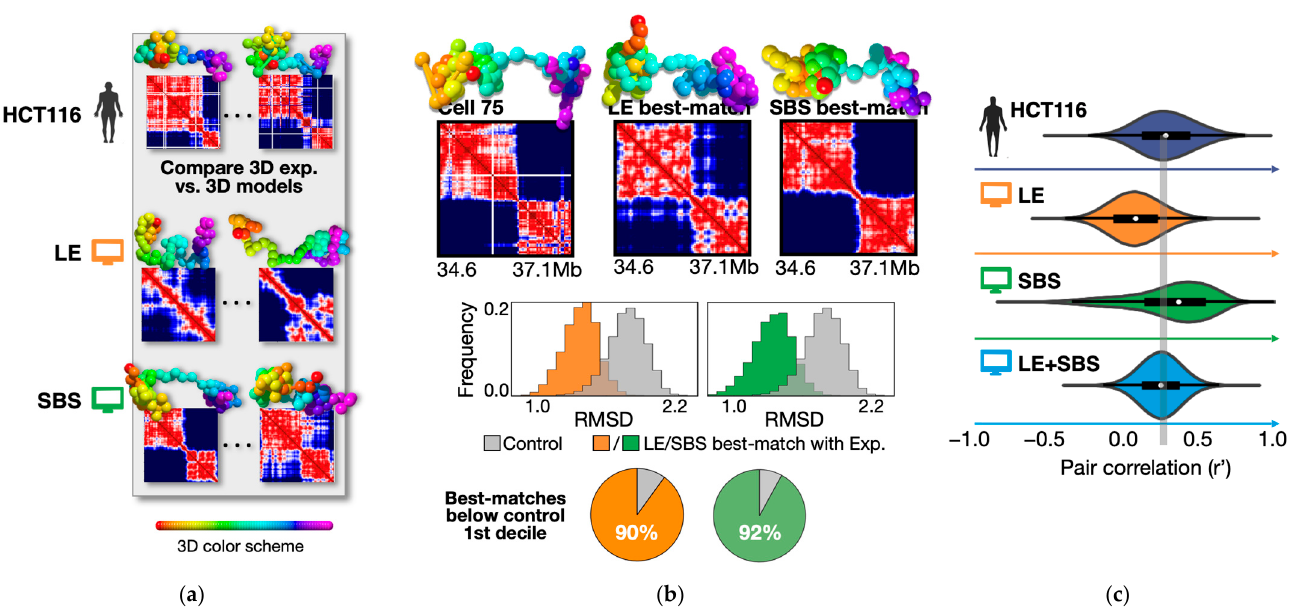
Figure 3. LE and SBS cooperate in determining the heterogeneity of chromatin architectures in single cells. ( a ) Schematic of the all-against-all structural comparison between microscopy [13] and model [65] 3D structures. ( b ) Top: example of experiment–model best-match association via the RMSD criterion. Middle: the identified RMSD best matches are statistically significant in the LE and SBS models (two-sided Mann–Whitney p -value < 10 − 3 , RMSD are z-scored on the x -axis). The control is the distribution of RMSD values for randomly taken pairs of experimental conformations. Bottom: more than 90% of the model best matches fall below the first decile of the control distribution. ( c ) The degree of cell-to-cell structural variability is quantified by an all-against-all pair correlation of single-molecule distance matrices. While LE (orange distribution) and SBS (green), respectively, under- and over-estimate the experimental distribution (blue) of pair correlations, a model combining both processes at the single-cell level (LE + SBS, light blue) best explains the data, hinting that LE and SBS cooperate in determining chromatin structure and its observed cell-to-cell heterogeneity. The dashed vertical line is the average value of the experimental distribution. Adapted from [64,65].